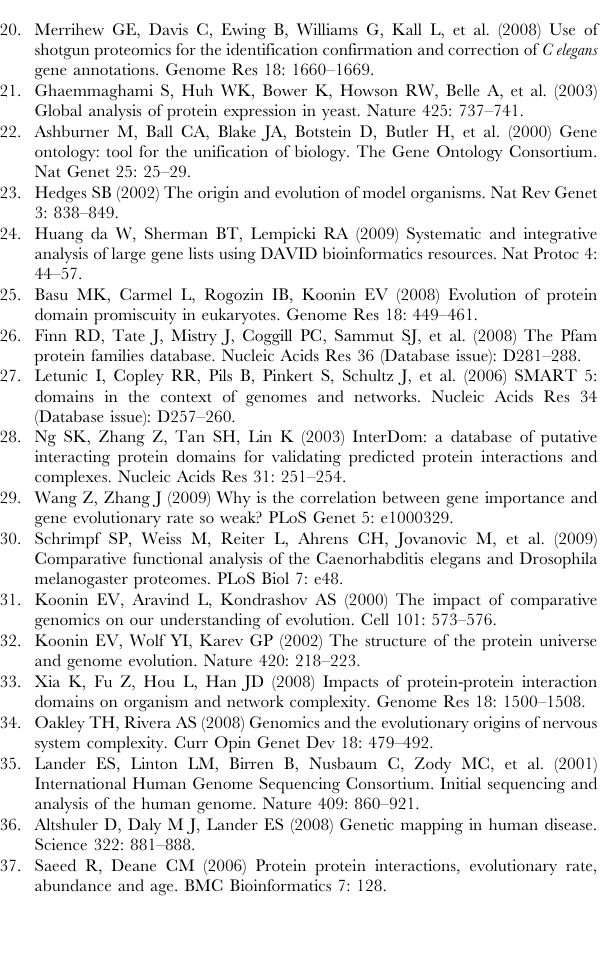
Table S6 Rank sum test p-values between proteins’ abundance datasets of three bio-molecules biogenesis machines across six